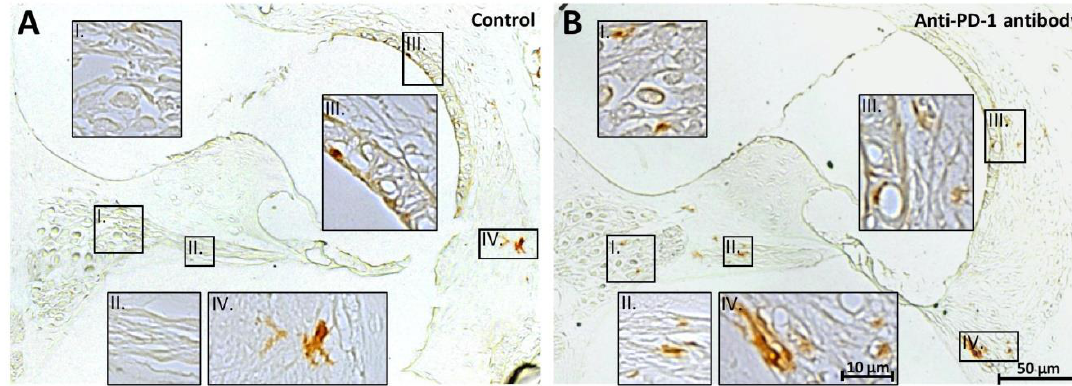
Figure 4. Immunohistochemical staining of the basal cochlear turn with anti-mouse-Iba1 antibody. The macrophage-specific Iba1 staining shows a moderately higher intensity 3,3′-diaminobenzidine DAB staining (i.e., higher macrophage signal) in the anti-PD-1 antibody-treated than in the control animals (representative sections from control ( A ) and anti-PD-1 antibody-treated ( B ) animals). The number of Iba1-positive cells was 1.56 times higher in the basal cochlear turn of the ICI-treated mice (control, n = 2; anti-PD-1 antibody-treated, n = 3). Roman numerals indicate enlarged areas of the Rosenthal’s canal (I), the peripheral processes of the SGNs (II), the stria vascularis (III), and the spiral ligament (IV). The details of the staining procedure are described in the Methods.